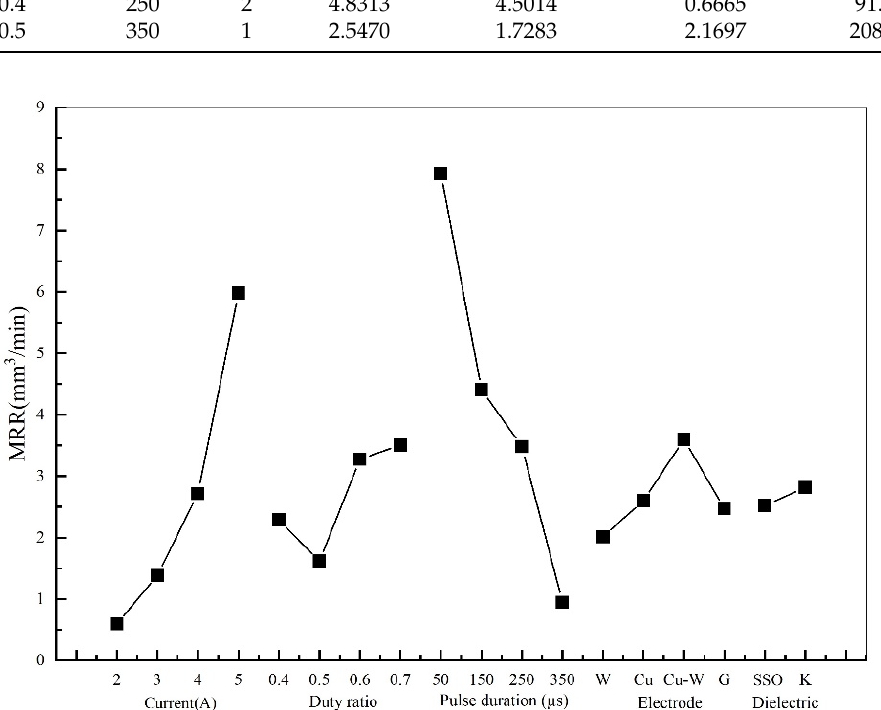
Figure 3. The influence of low-viscosity and high-viscosity dielectrics on discharge channels and processing performance. 3.1.2. Ra Ra is the small pitch and the unevenness of the microscopic valleys on the surface of the workpiece. The larger the Ra, the rougher the surface of the workpiece, and the greater the friction of the workpiece when in contact. Therefore, a lower Ra is beneficial to the